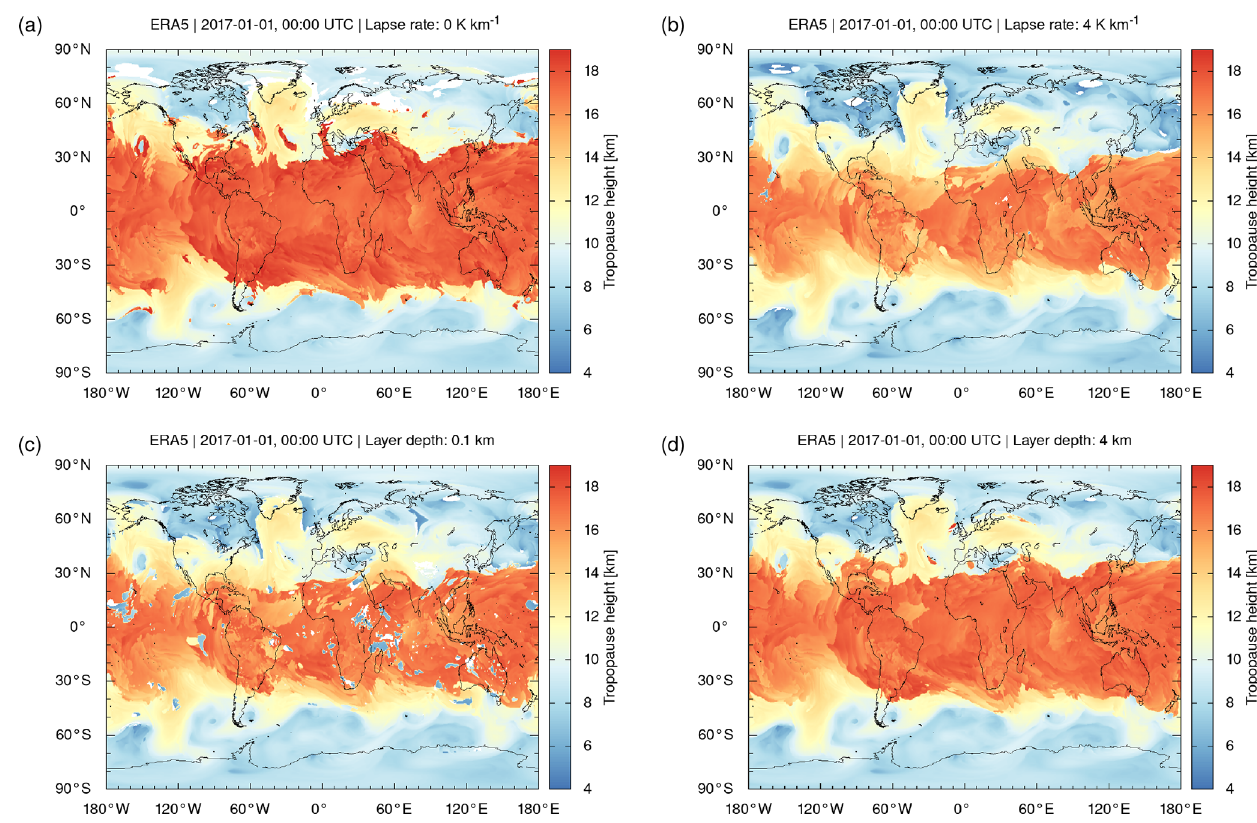
Figure 15. Global maps of ERA5 thermal tropopause geopotential heights on 1 January 2017, 00:00UTC, for different lapse rates (a, b) and layer depths (c, d) . Compare Fig. 2a for